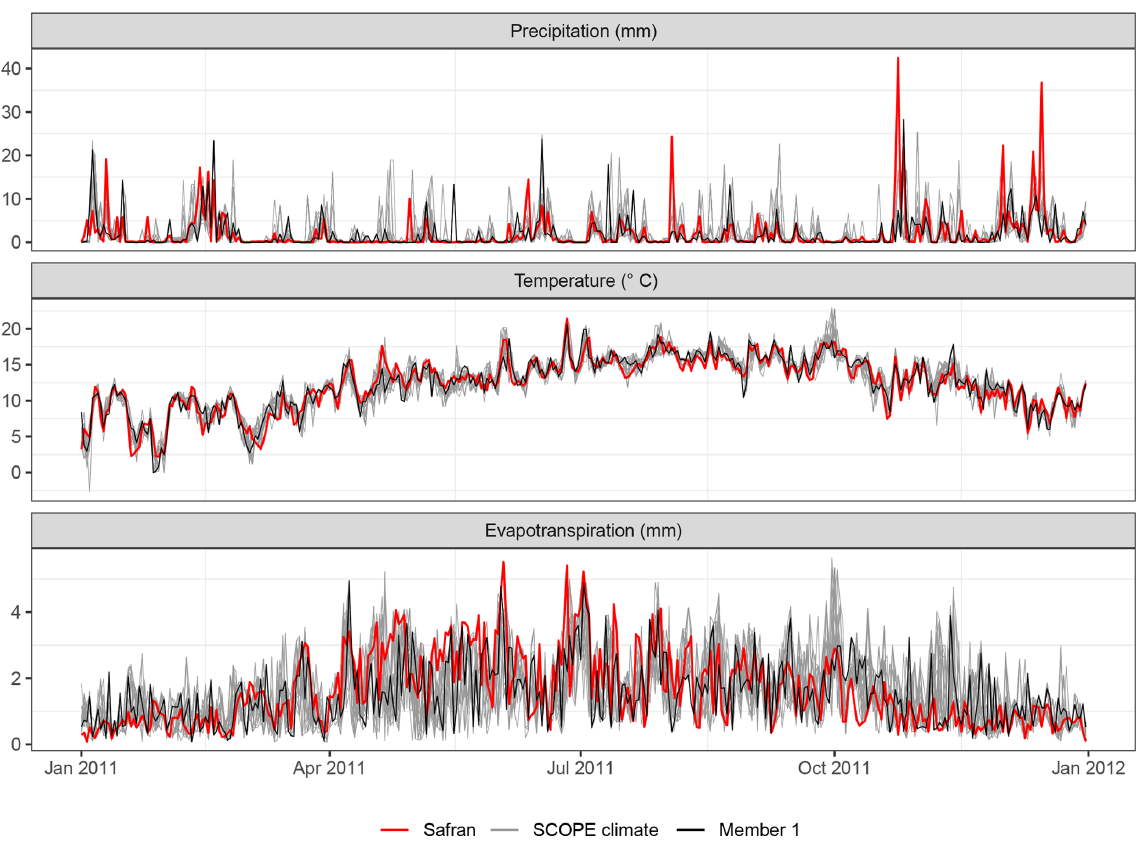
Figure 8. Precipitation, temperature, and reference evapotranspiration reconstructed series from SCOPE Climate compared to Safran in 2011 at a daily time step for the Finistère grid cell (see Fig. 7). Light grey time series correspond to the 25 members of SCOPE Climate, Member 1 is plotted in black for exemplifying autocorrelation in individual member time